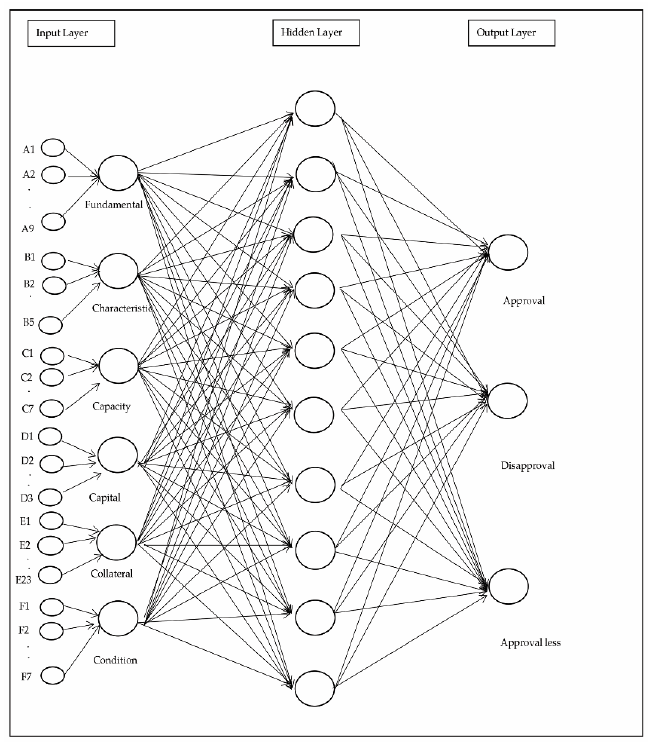
Figure A5. Structure of the NN by full factor model used for predicting.